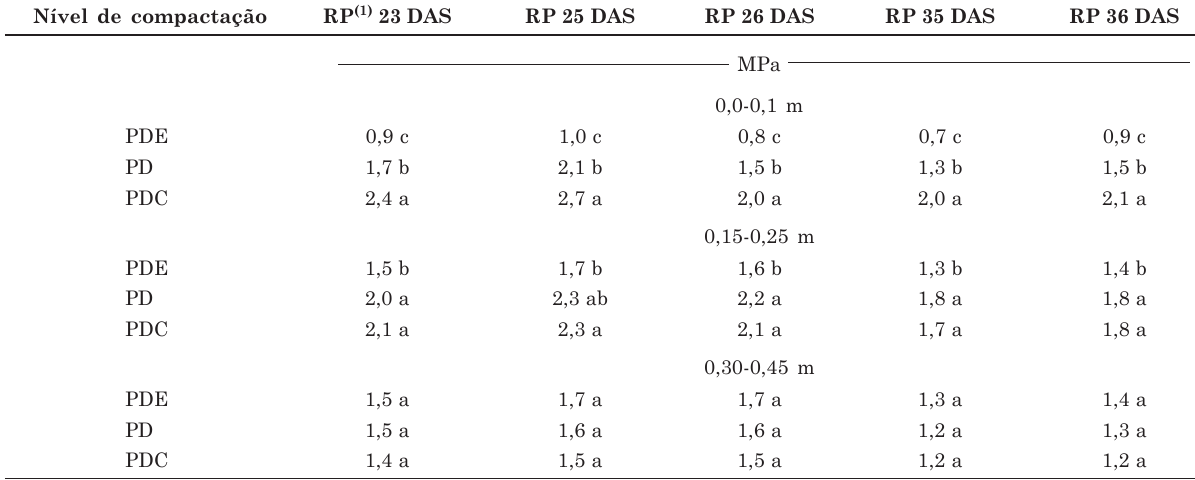
(1) RP representa a resistência do solo à penetração e o número representa o dia após a semeadura (DAS); PDE: plantio direto escarificado; PD: plantio direto; e PDC: plantio direto compactado. Médias na coluna de cada camada seguidas pela mesma letra não diferem estatisticamente entre si pelo teste de Tukey a 5 %.